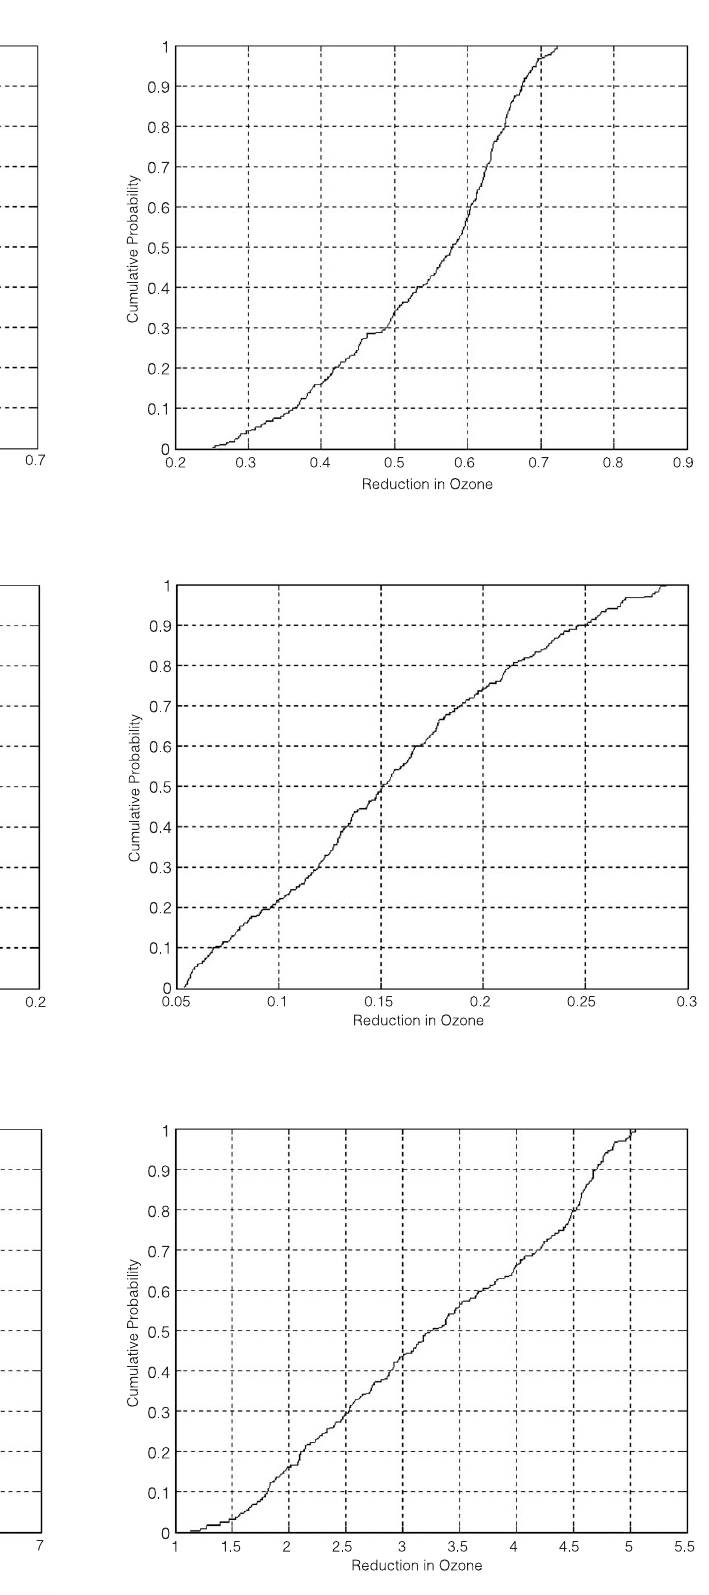
Fig. 5. Cumulative frequency of S 1O3 j ( j = O the boundary conditions of O